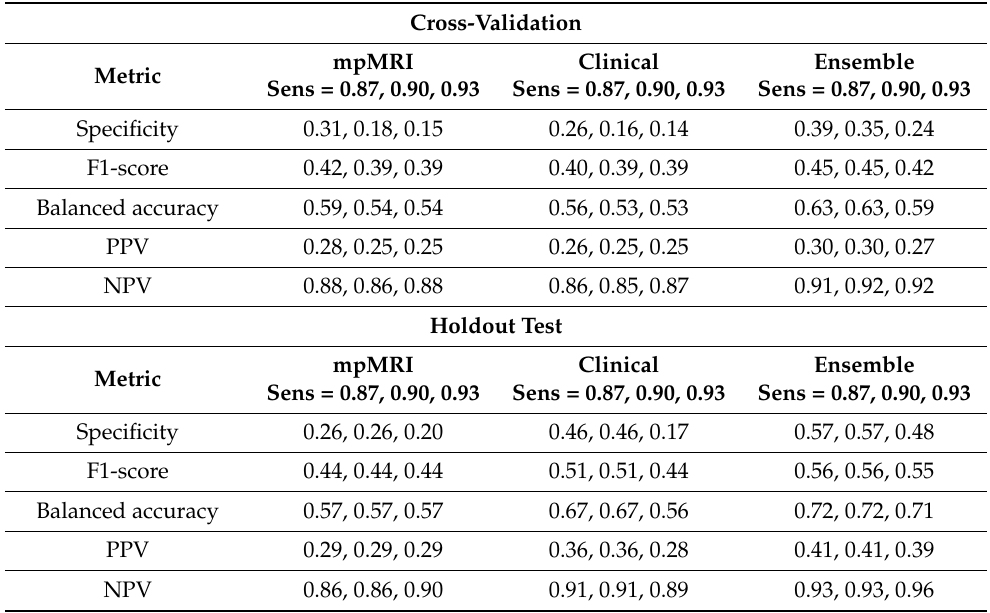
Table 3. Cross-validation and holdout test of the per-modality models and the ensemble model at sensitivity operation points 0.87, 0.90, and